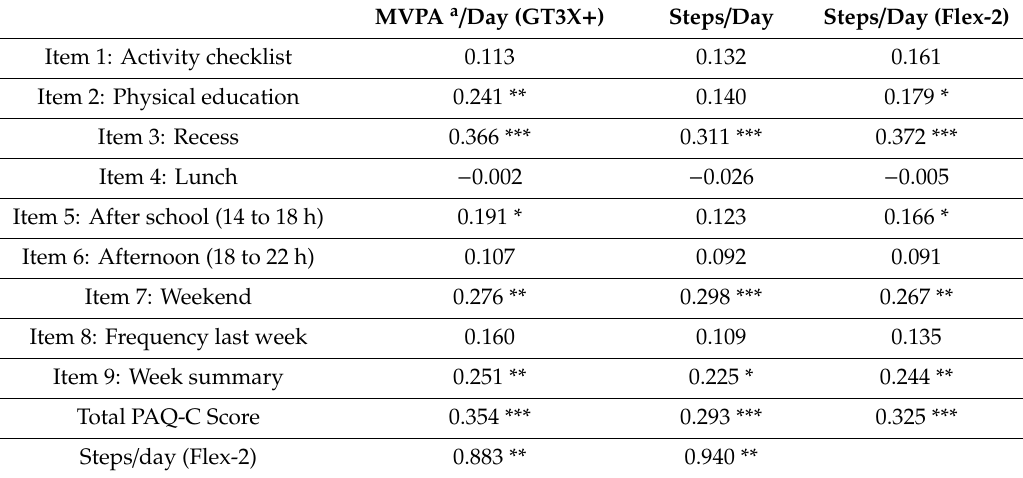
Table 2. Correlations among PA data provided by the PAQ-C, the Fitbit Flex-2 and the GT3X +